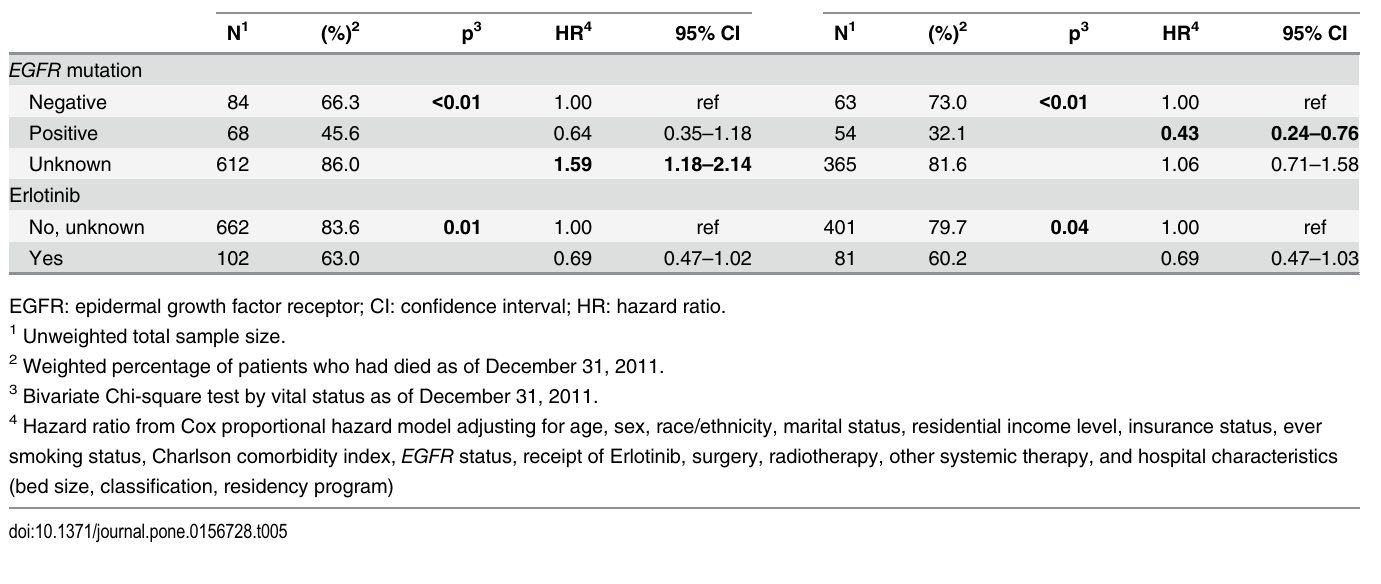
Table 5. Association between EGFR -mutant status and Erlotinib treatment with all-cause survival among patients diagnosed in 2010 with stage IV non-small cell lung cancer, Patterns of Care. All